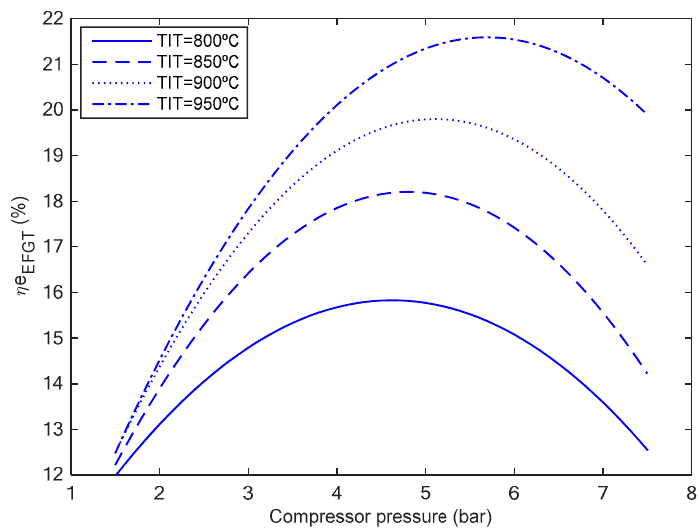
Figure 5. EFGT electrical efficiency ( η e pruning biomass).